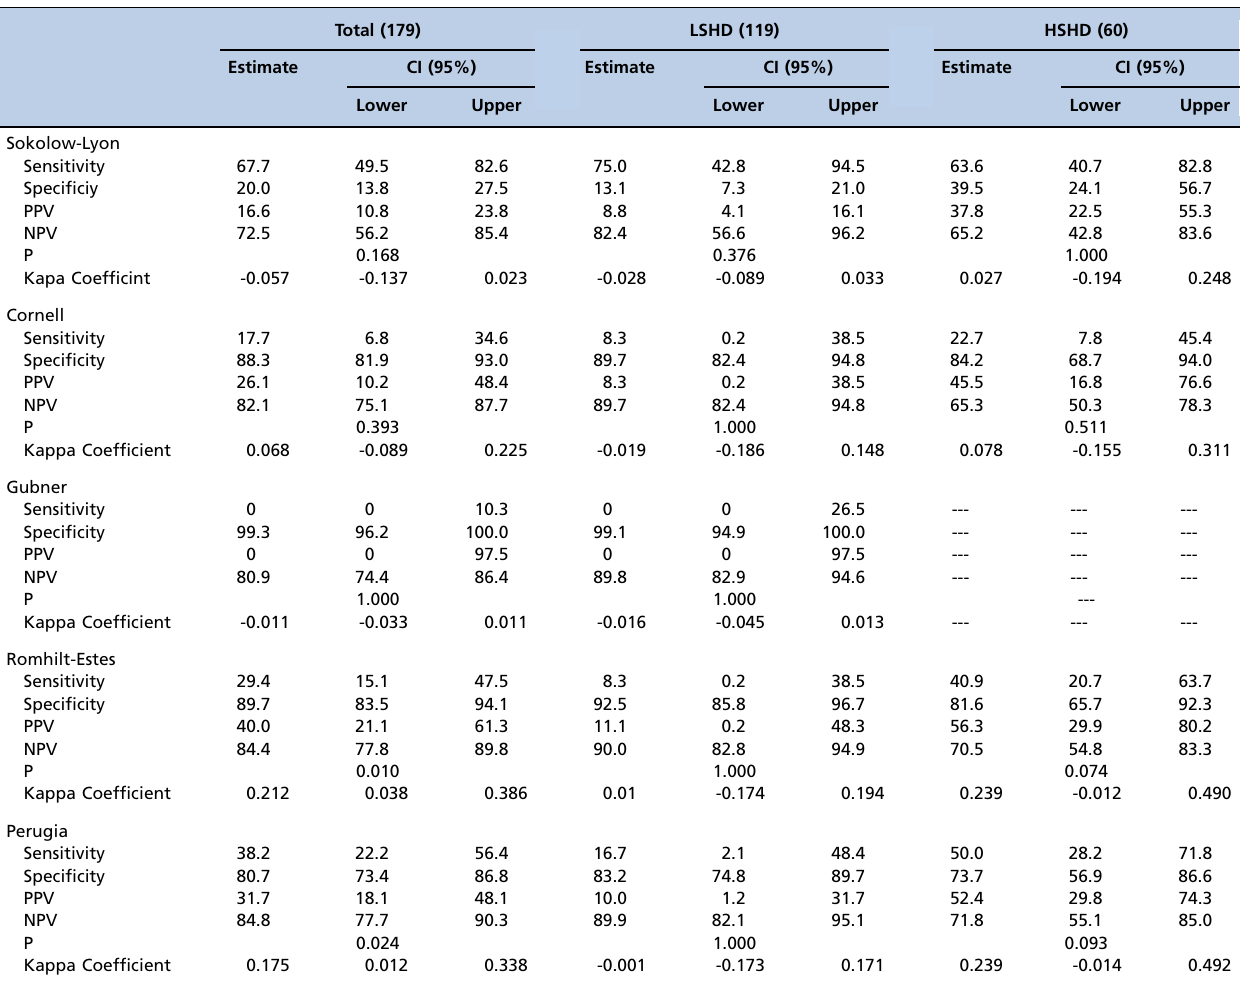
Table 3 - RWT x Electrocardiogram